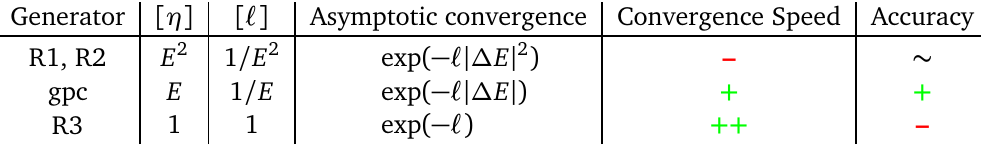
Table 2: Results of the analytical analysis and numerical benchmark for the gener- ators considered in this work. The dimension of η and ℓ are given in terms of the energy E and the asymptotic convergence in terms of the energy differences ∆ E of the system. The convergence speed and the accuracy (during truncation) are de- picted by + for positive results, – for negative results and ∼ for mixed results. Generator [ η ] [ ℓ ] Asymptotic convergence Convergence Speed Accuracy R1, R2 E 2 1 / E 2 exp ( − ℓ | ∆ E | 2 ) – ∼ gpc E 1 / E exp ( − ℓ | ∆ E | ) + + R3 1 1 exp ( − ℓ )